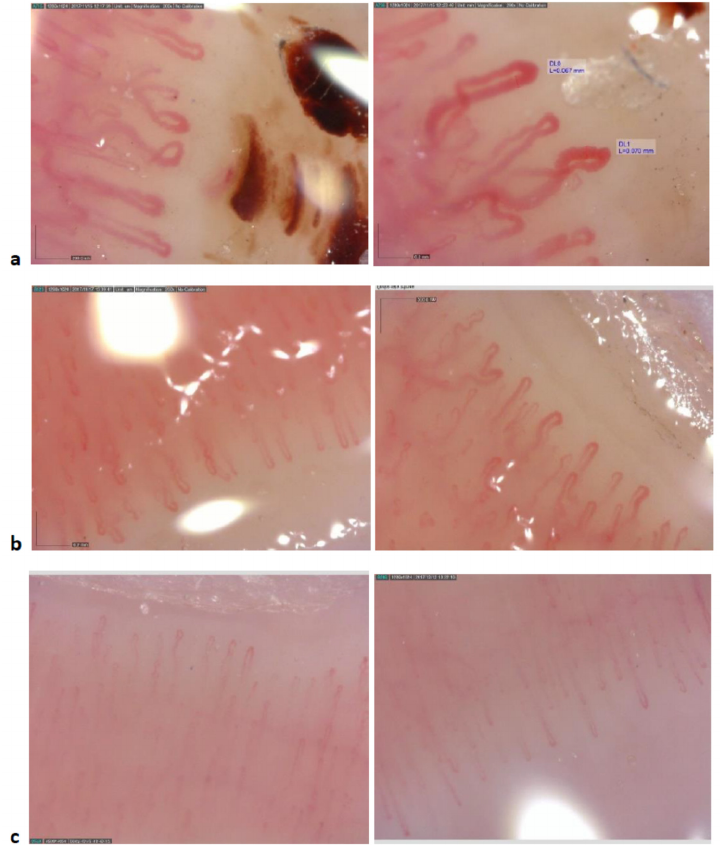
Figure 1. The nailfold capillaroscopic pattern: ( a ) hand allografts; ( b ) healthy hands in patients after limb transplantation; ( c ) hands in patients after kidney transplantation.